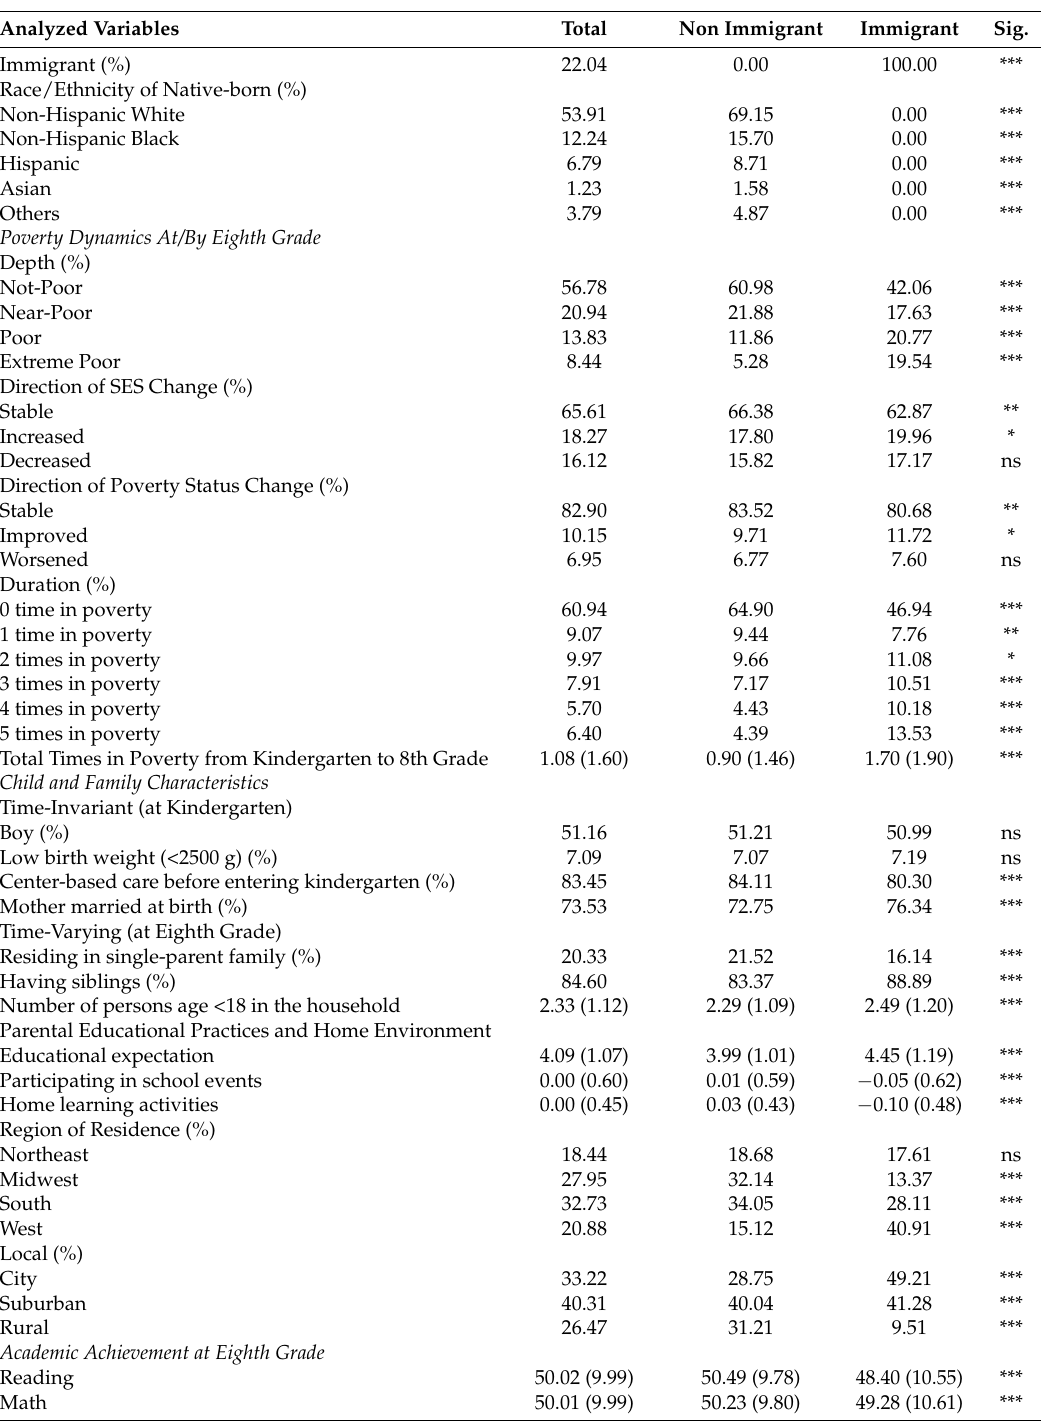
Table 1. Child and family characteristics by immigrant status ( N ≈